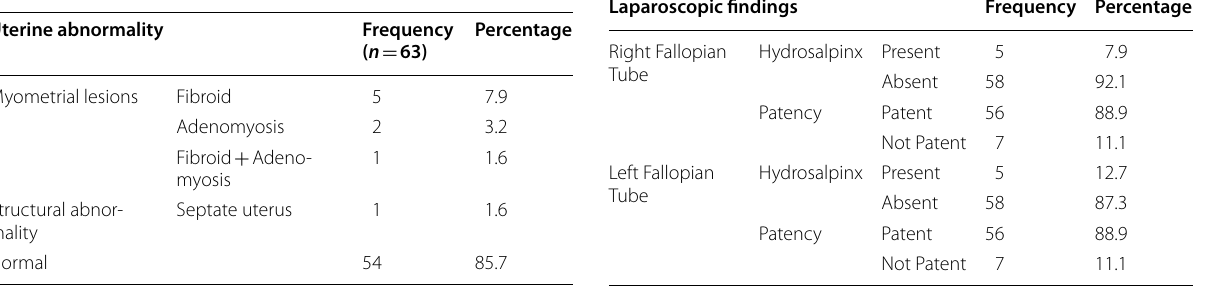
Table 1 Uterine abnormality on MRI